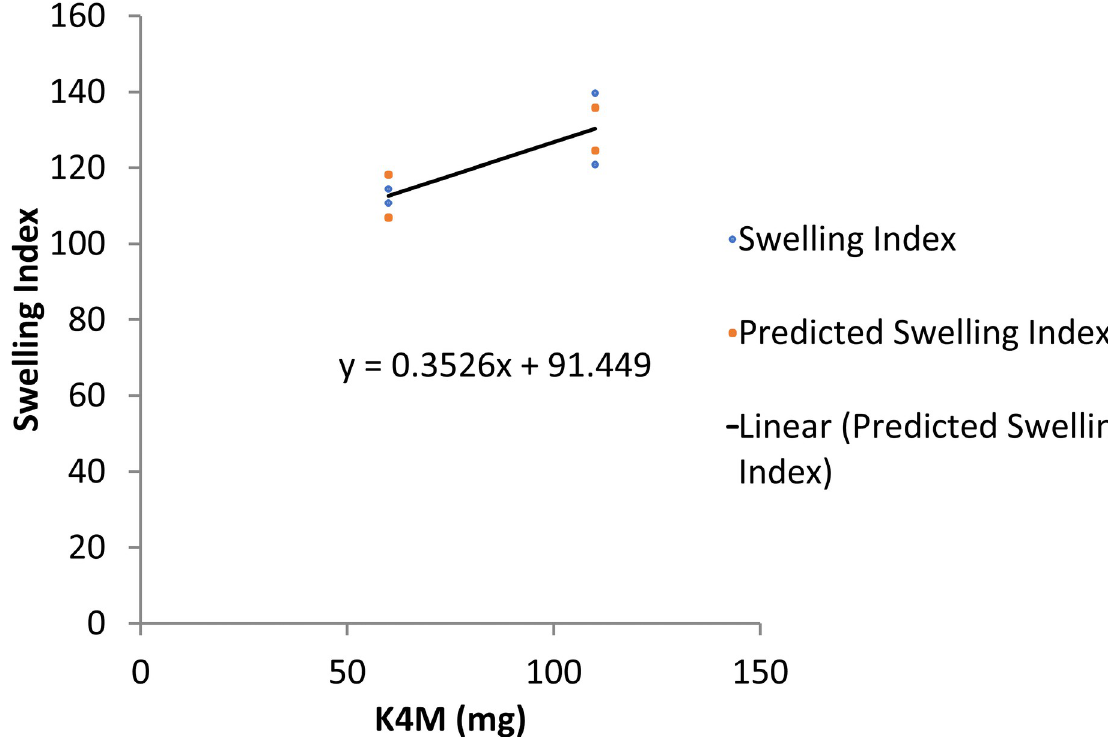
Fig 7. Line fit plot for the response of swelling index with HPMC